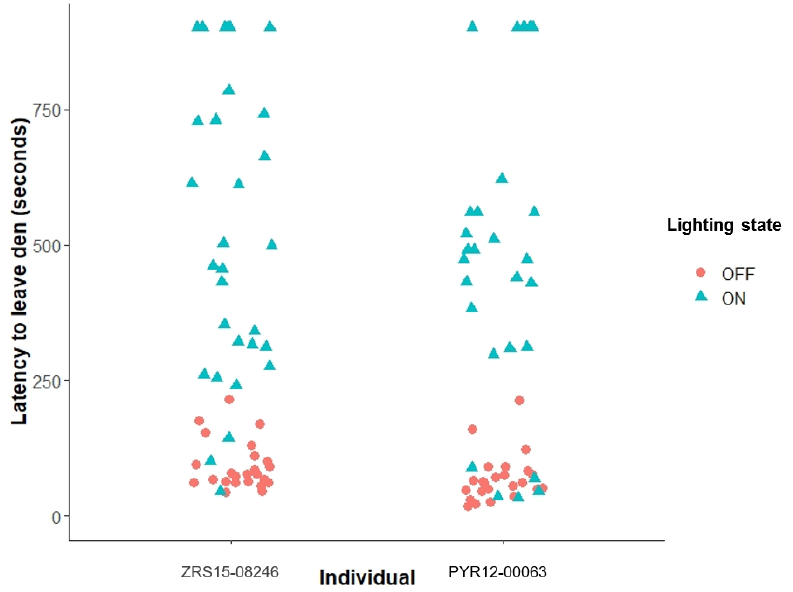
Figure 1. Latency for both individual macaws, ZRS15-08246 and PYR12-00063, to leave the den after recall under different T5 lighting statuses—on or off. Mean data between individuals were used for